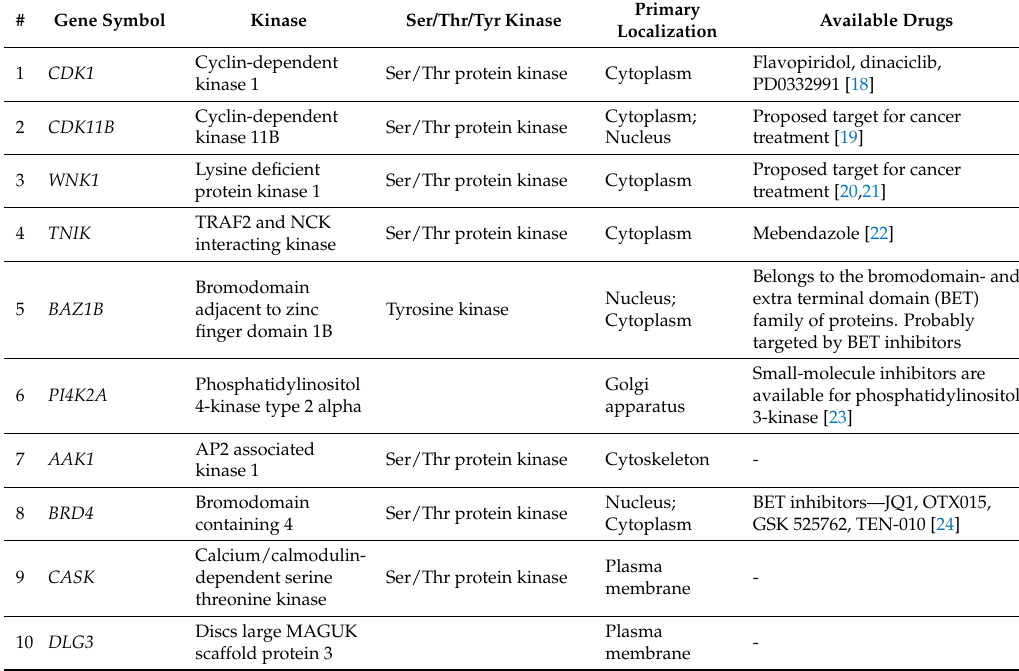
Table 2. List of kinases identified to be hyperphosphorylated in